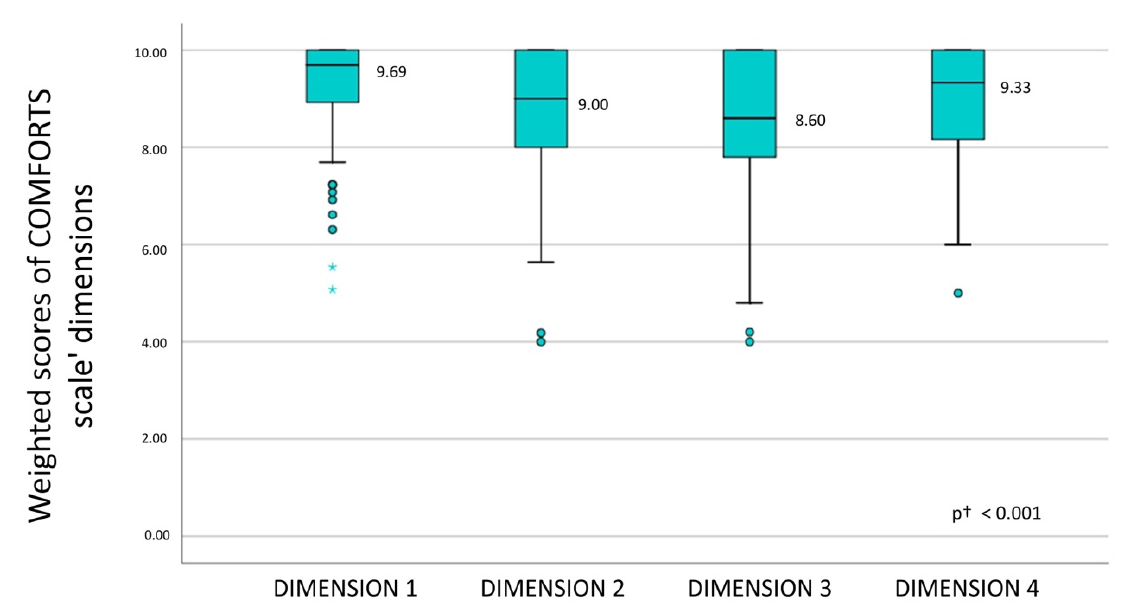
Figure 1. Scores of COMFORTS scale’ dimensions. † Friedman test. Table 3. Analysis of factors associated with COMFORTS scale